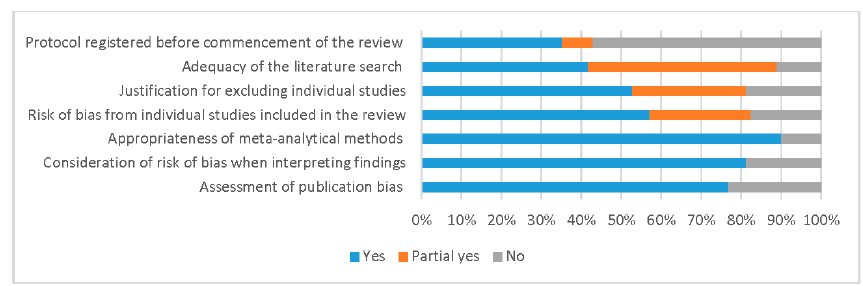
Figure 2. Quality assessment of reviews with meta-analyses.